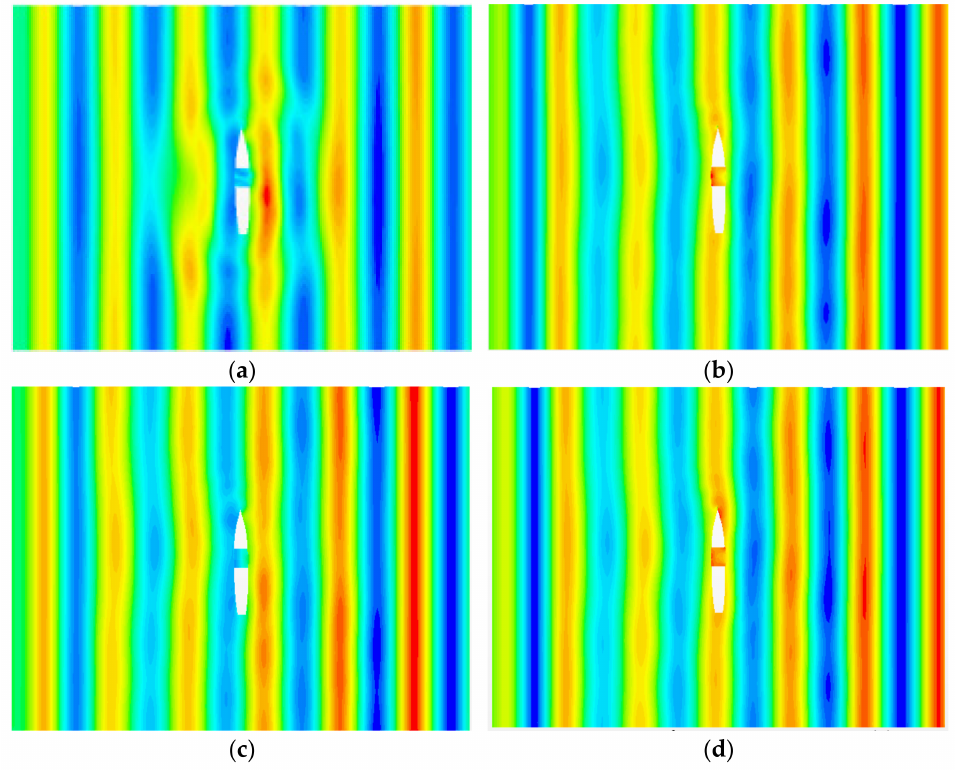
Figure 11. A snapshot of the free surface contour with the damaged ship in beam waves. ( a ) Prediction stage, t = 5 s; ( b ) Prediction stage, t = 15 s; ( c ) Transition stage, t = 23 s; ( d ) Correction stage, t = 30